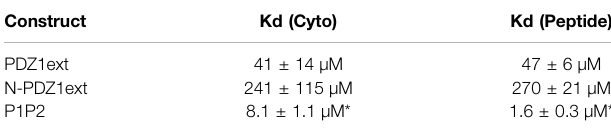
TABLE 3 | Kd values measured for PDZD7 constructs against ADGRV1 whole cytoplasmic domain (cyto) or last 13 residues (peptide) (PDZ1ext and N-PDZ1ext by NMR titration; P1P2 by fl uorescence titration). For fl uorescence, the error derives from the quality of the fi t (marked as *). For NMR, errors derive from the standard deviations of the measured Kd values for at least ten signi fi cantly shifting